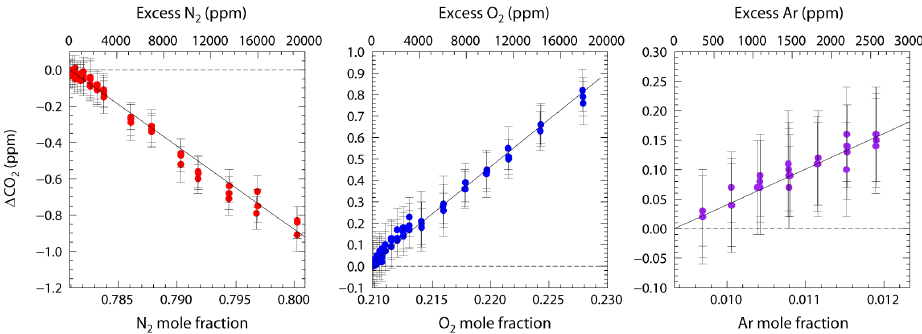
Figure 2. Relationship between excess mole fraction of inert gases relative to their ambient levels and the resulting pressure-broadening effects on CO 2 measurements for WS-CRDS model G-1301. For each plot, the bottom axis indicates the increase in the amount of added inert gas in the sample air relative to the gas’s ambient level, and the top axis indicates the relative increase in inert gas with respect to the bottom axis. The vertical bars in each plot denote the standard deviation ( ± 1 σ) determined from the precision of WS-CRDS measurements and the flow meter. Errors in the calculation of N 2 , O 2 , and Ar mole fraction are less than 74, 75, and 19ppm, respectively. The solid line is the relationship between the changes in matrix gas composition resulting from the inert gas addition and pressure-broadening effects, as calculated by linear least squares analysis.